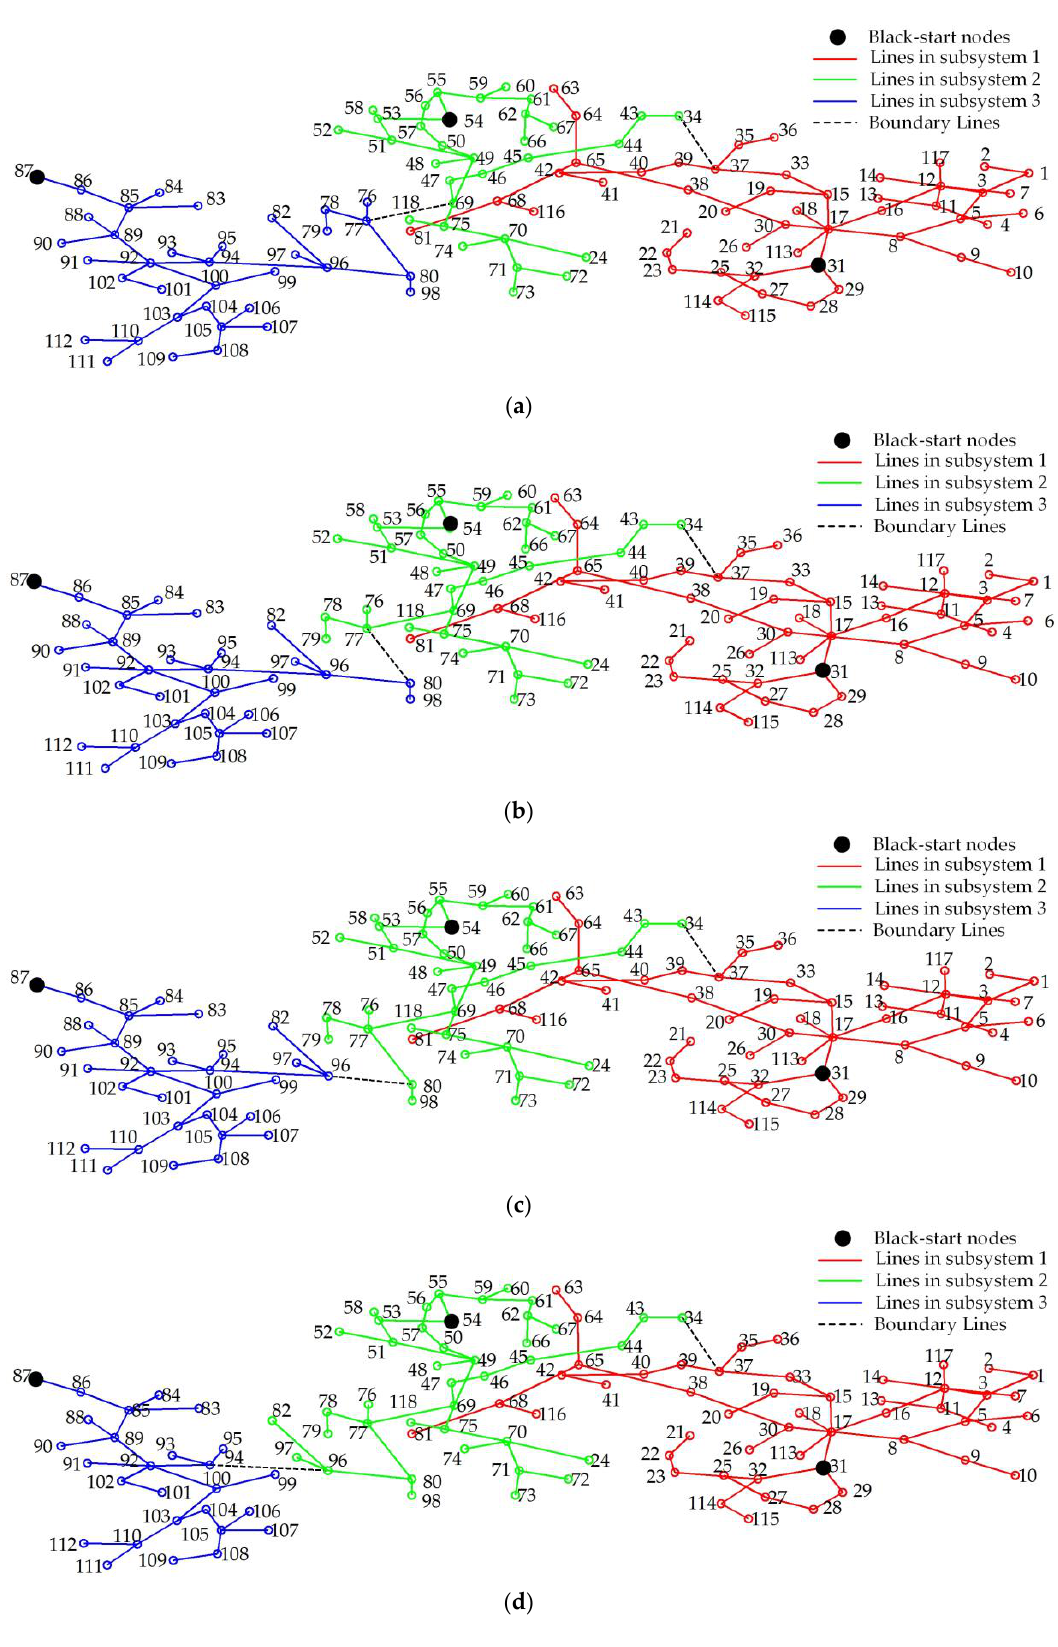
Figure 9. Optimal sectionalizing schemes in Scenario 1: ( a ) Scheme 1; ( b ) Scheme 2; ( c ) Scheme 3; and ( d ) Scheme 4.